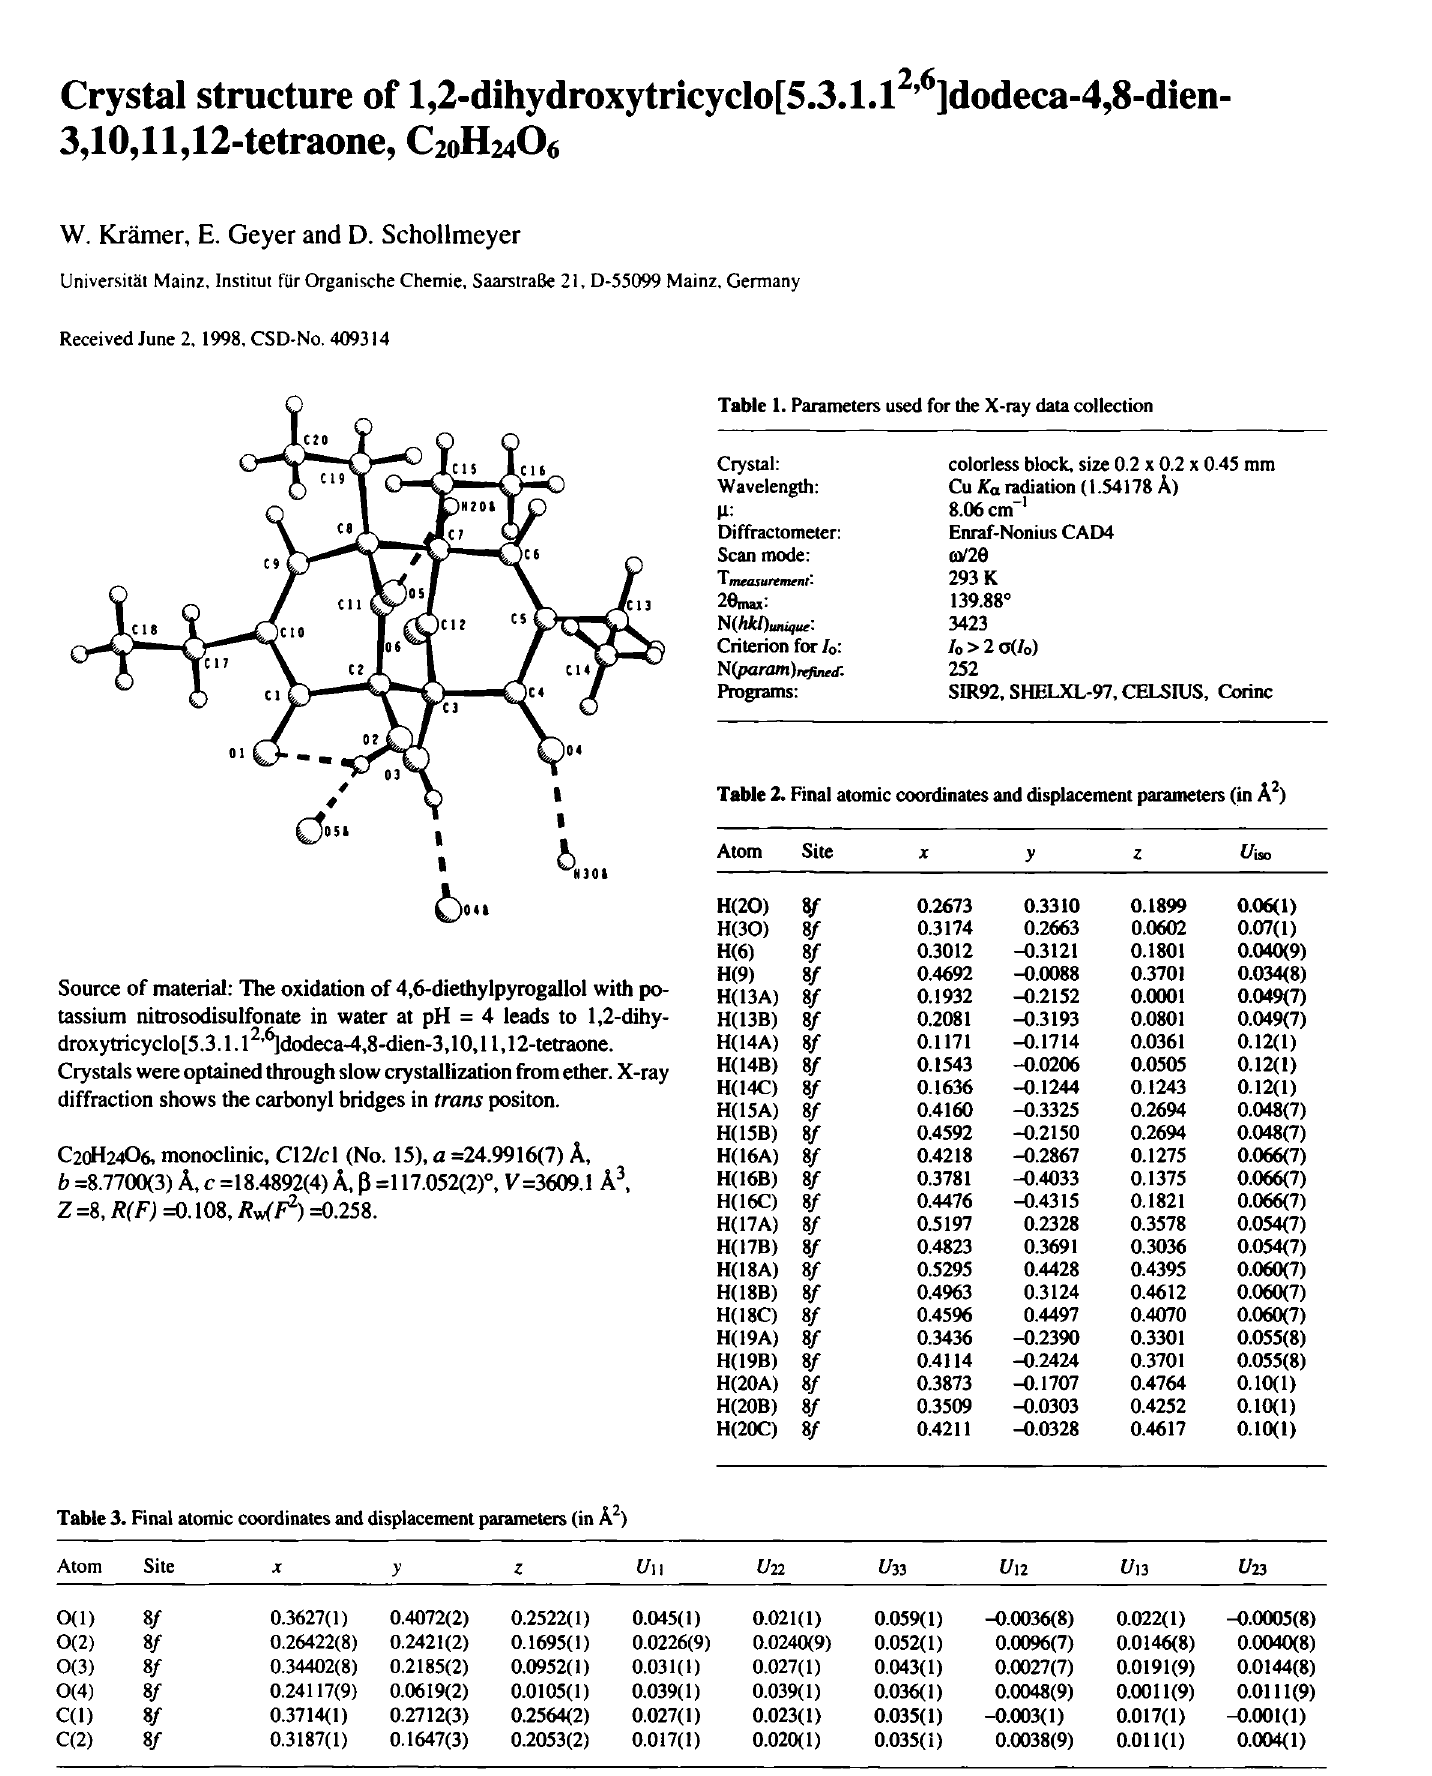
Table 1. Parameters used for the X-ray data collection